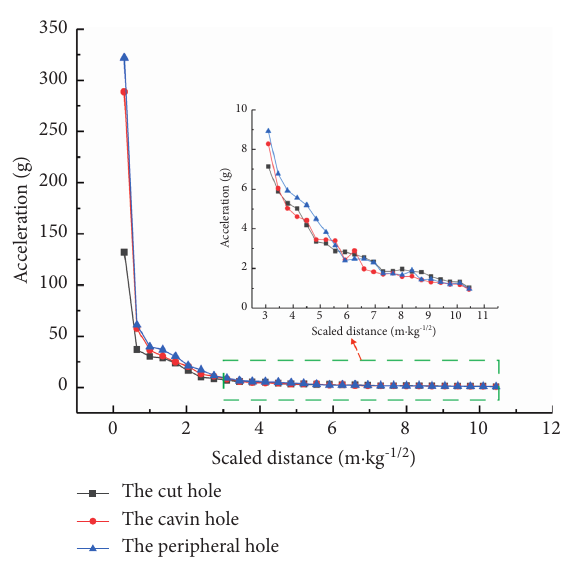
Figure 12: Attenuation curves of vibration acceleration of different blast